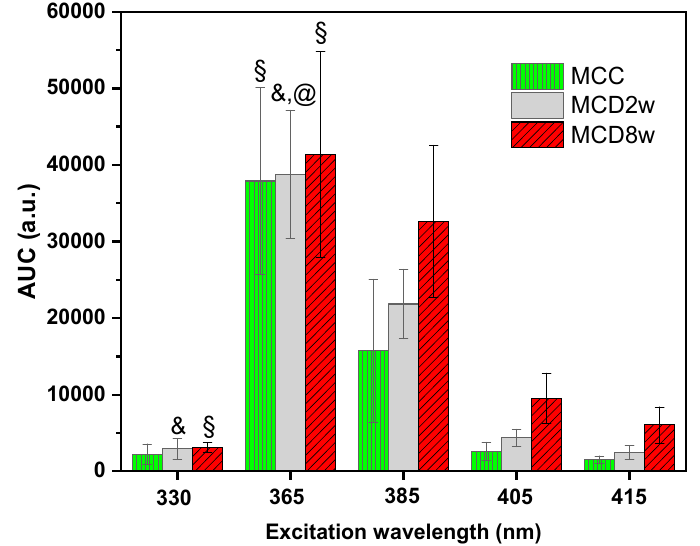
Figure 2. Area under the curve (AUC) of the spectra measured on liver samples of the three di ff erent groups MCC, MCD2w and MCD8w—at di ff erent excitation wavelengths indicated in the horizontal axis. The bar heights correspond to the mean AUC value for one group and the error-bars stand for the corresponding standard deviation. The symbols over some of the bars indicate that the null hypothesis that the given group is significantly di ff erent from some other group could be rejected at p <